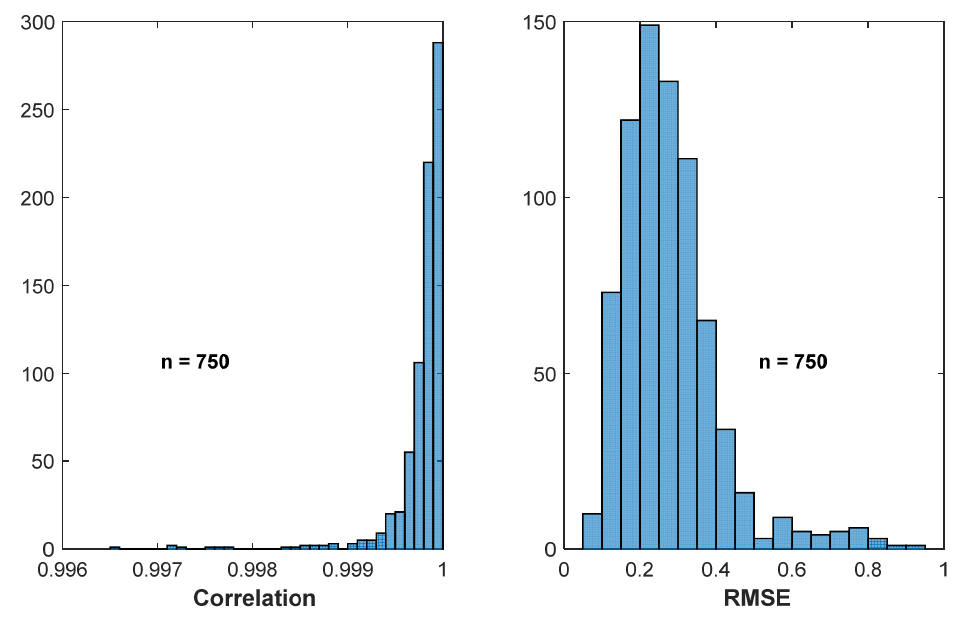
Figure 11. Correlation and RMSE between original and reconstructed thigh angles for each stride.